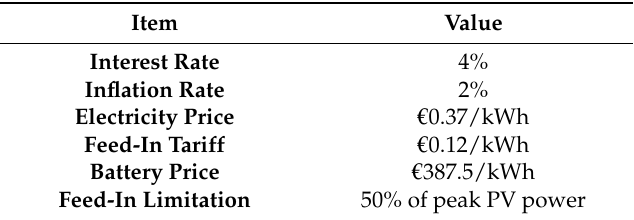
Table 2. Overview of financial parameters. PV: photovoltaic.